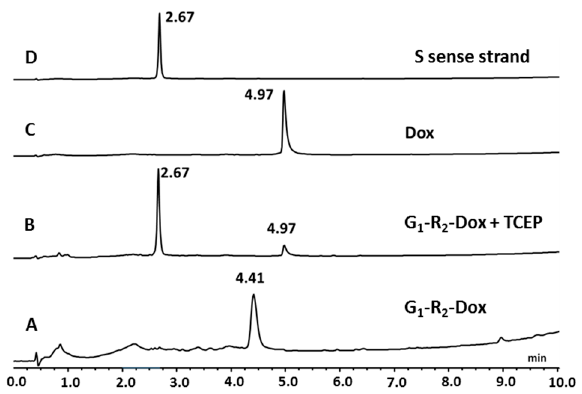
Figure 5. RP-HPLC profiles at 260 nm of A ) G 1 -R 2 -Dox conjugate; B ) crude mixture of G 1 -R 2 -Dox conjugate after 24 h incubation with TCEP at 37 °C; C ) doxorubicin and D ) RNA S sense strand of siEF-4.